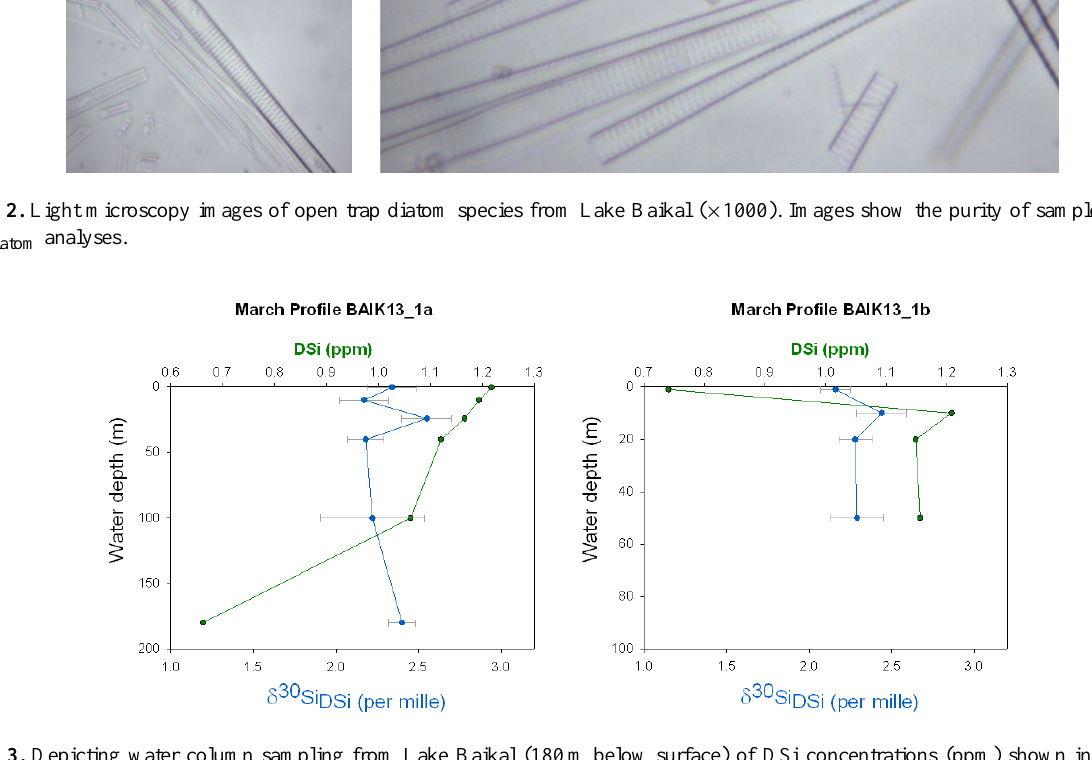
Figure 3. Depicting water column sampling from Lake Baikal (180m below surface) of DSi concentrations (ppm) shown in green and δ 30 Si DSi (‰) signatures in blue. The two sampling intervals (BAIK13-1a and 1b) from March 2013 are both displayed. Note the different sampling depths for these two data sets. All analytical errors of uncertainty are shown in grey (2 σ ). All data correspond to Table